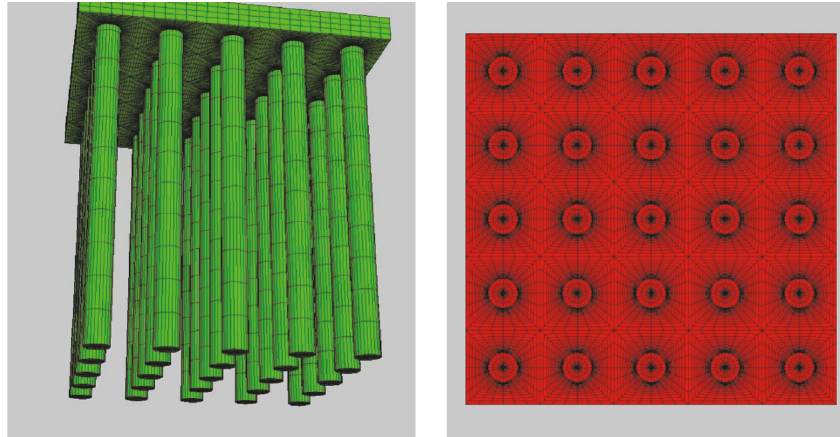
Figure 5: Two different grid sizes used to carry out the sensitivity analysis on the mesh sizes.